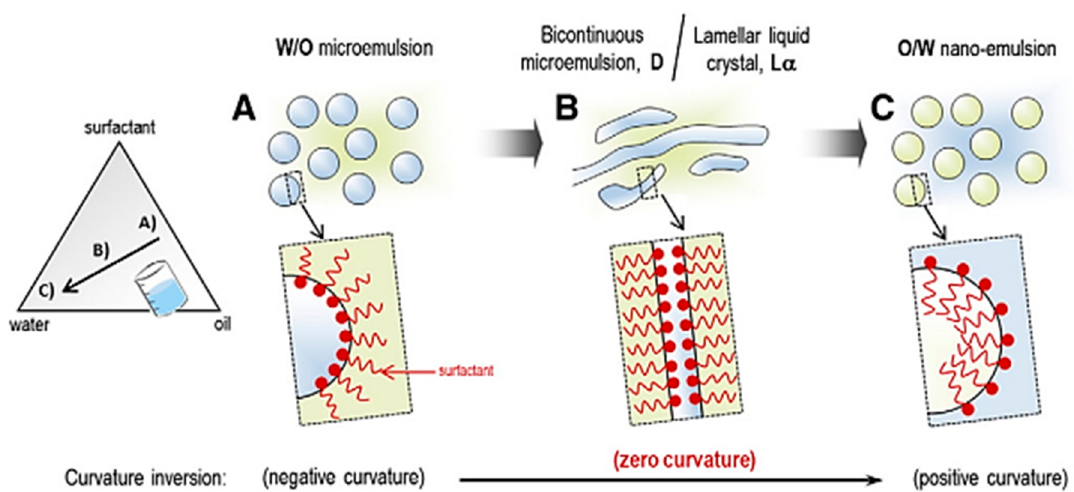
Figure 4. Schematic representation of the production of NEs by the Phase Inversion Composition (PIC) method. Reproduced with permission from Solans & Solé, Current Opinion in Colloid & Interface Science; published by Elsevier, 2012 [70].